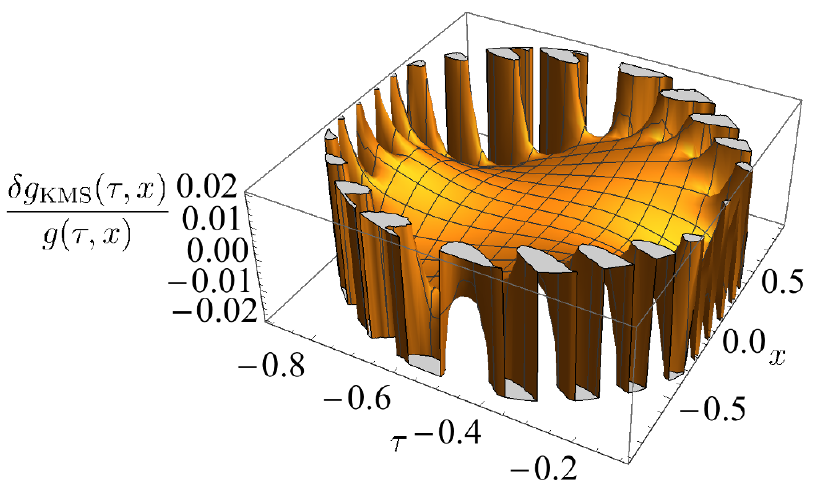
Figure 6. Evidence of how well the KMS condition is satis(cid:12)ed in the ( (cid:28); x ) plane in the region of OPE convergence. We plot the di(cid:11)erence of the two-point function and it’s periodic image, (cid:14)g KMS ( (cid:28); x ) = g (1 + (cid:28); x ) (cid:0) g ( (cid:28); x ), using the average thermal coe(cid:14)cients presented in (cid:12)gure 4. Note that towards the boundary of the region of OPE convergence, our estimates for the two-point function become worse and the KMS condition is further from being satis(cid:12)ed. For the range ( (cid:28); x ) shown above the deviation from satisfying KMS is <